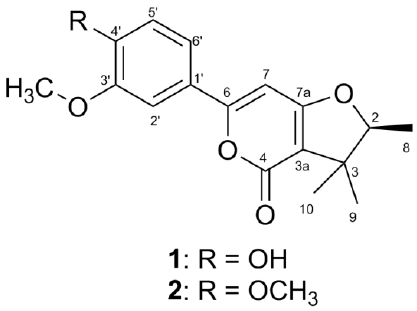
Figure 1. Structures of compounds 1 and 2 .